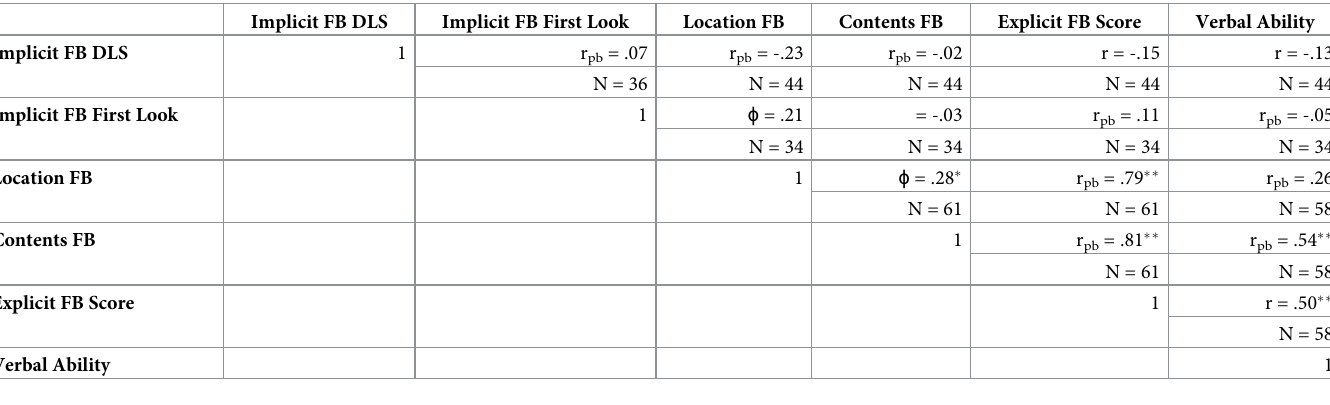
Table 1. Zero-order correlations between measures at Wave 2 in Experiment